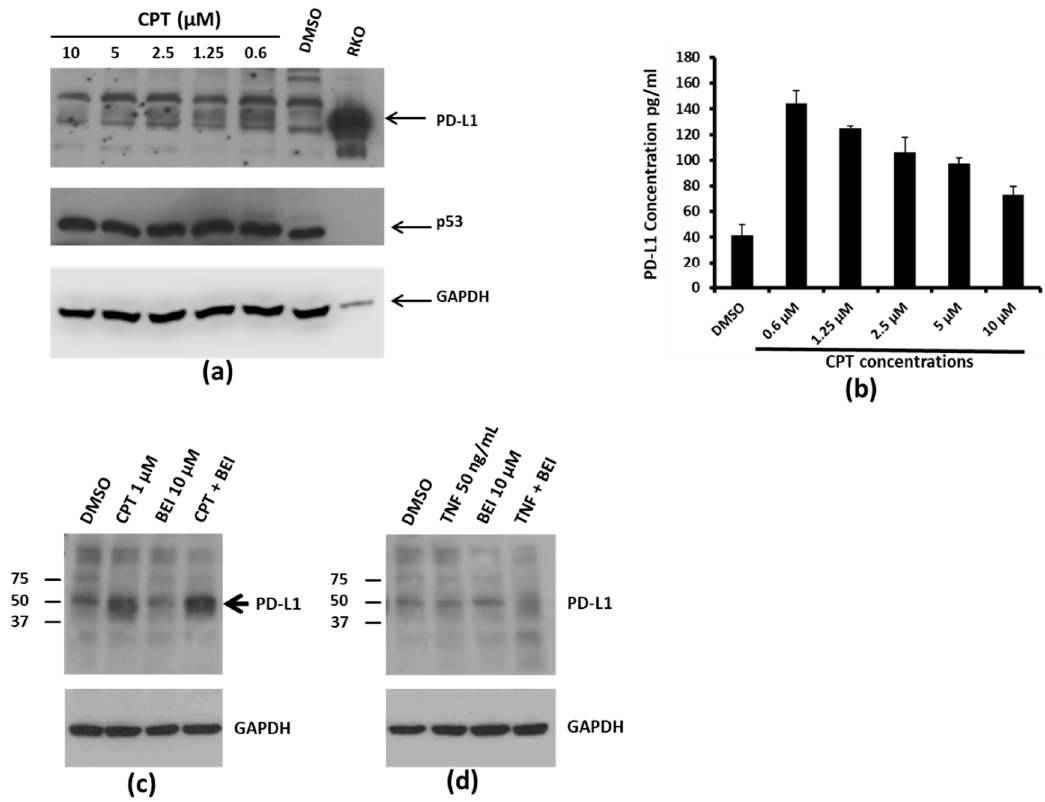
Figure 2. PD-L1 expression in response to CPT treatment. ( a ) SW620 cells were treated with the indicated concentrations of CPT for 24 h. The levels of PD-L1 in the cell lysates were evaluated by immunoblotting. p53 and GAPDH levels were also detected in the same lysates for drug response and for loading control, respectively. The RKO lysate was loaded on the same gel as a marker for detection of PD-L1, since RKO cells expressed the highest amounts of the protein per unit volume of lysate. Numbers below each panel indicate the relative integrated density of the protein band in that lane. ( b ) Cell lysates from SW620 cells treated with DMSO or increasing concentrations of CPT were prepared for ELISA. For this assay, 75 µ g of total protein was loaded per well. The Y-axis of the bar graph indicates concentrations in pg / mL. ( c ) SW620 cells were treated for 24 h with DMSO or CPT, or with CPT followed by 3-(2-bromoethyl)indole (BEI, an Nuclear Factor kappa-light-chain-enhancer of activated B cells (NF-kB) inhibitory compound) for another 24 h. The expression of PDL-1 was detected by immunoblotting using an anti-PD-L1 antibody. ( d ) SW620 cells were treated with DMSO, tumor necrosis factor alpha (TNF α ), or TNF α and BEI. PD-L1 expression was detected by immunoblotting. Neither TNF α nor cotreatment with BEI upregulated PD-L1 expression.